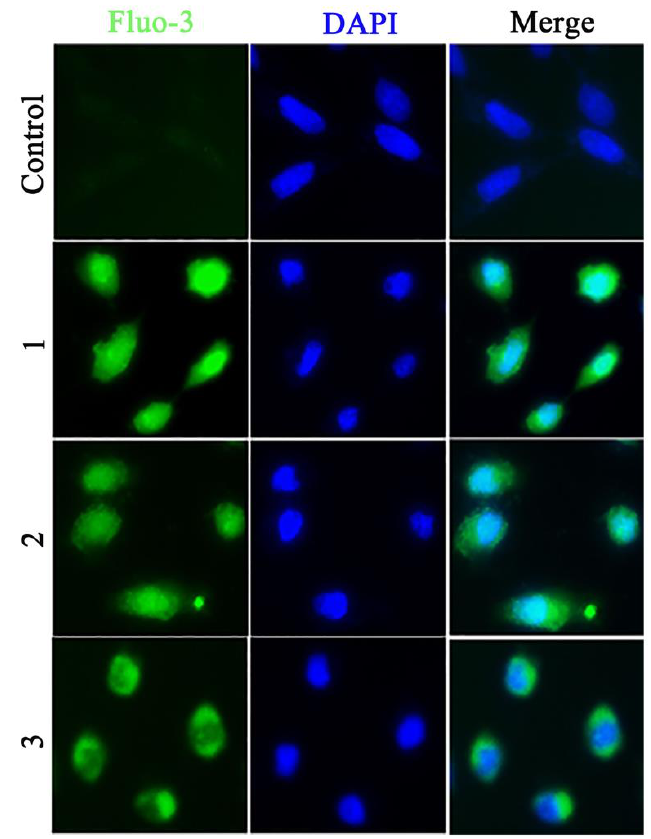
Figure 8. Intracellular Ca 2+ concentration assay after SGC-7901 cells were treated with 1 (4.0 µM), 2 (15.0 µM), or 3 (15.0 µM) for 24 h.